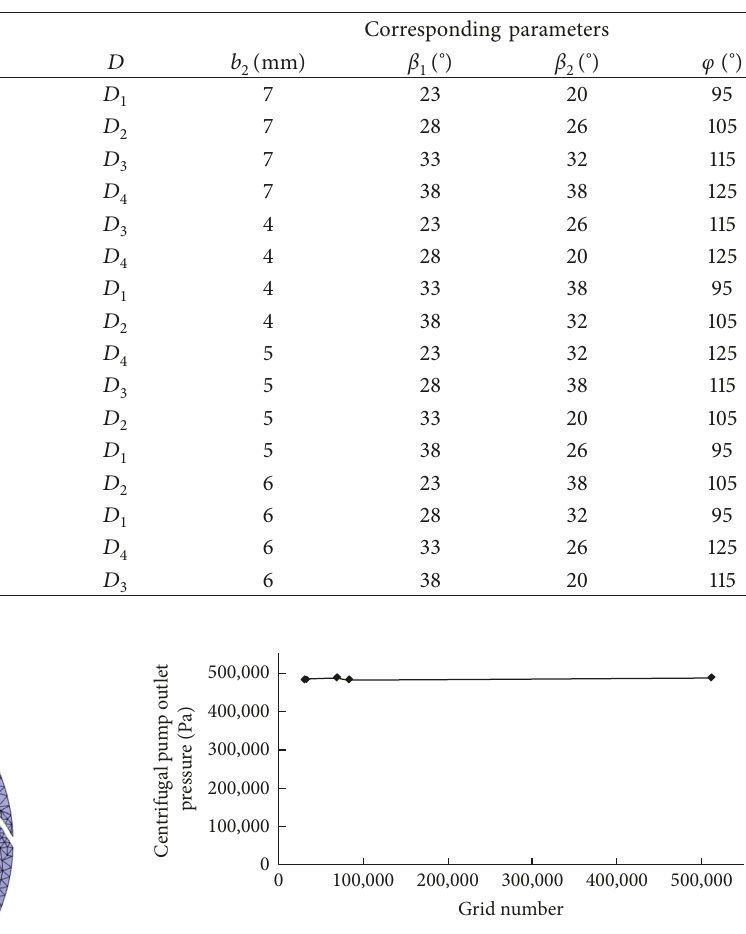
Figure 3: Distribution of centrifugal pump outlet